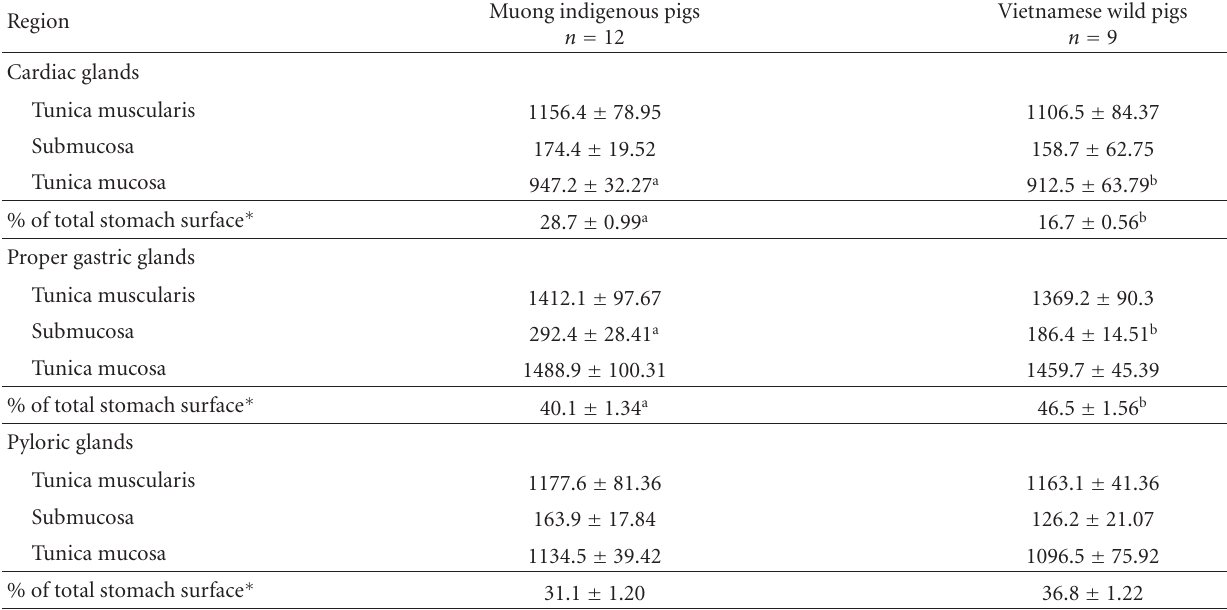
Table 2: Comparative histomorphometry of stomach gland regions ( µ m; Mean ±